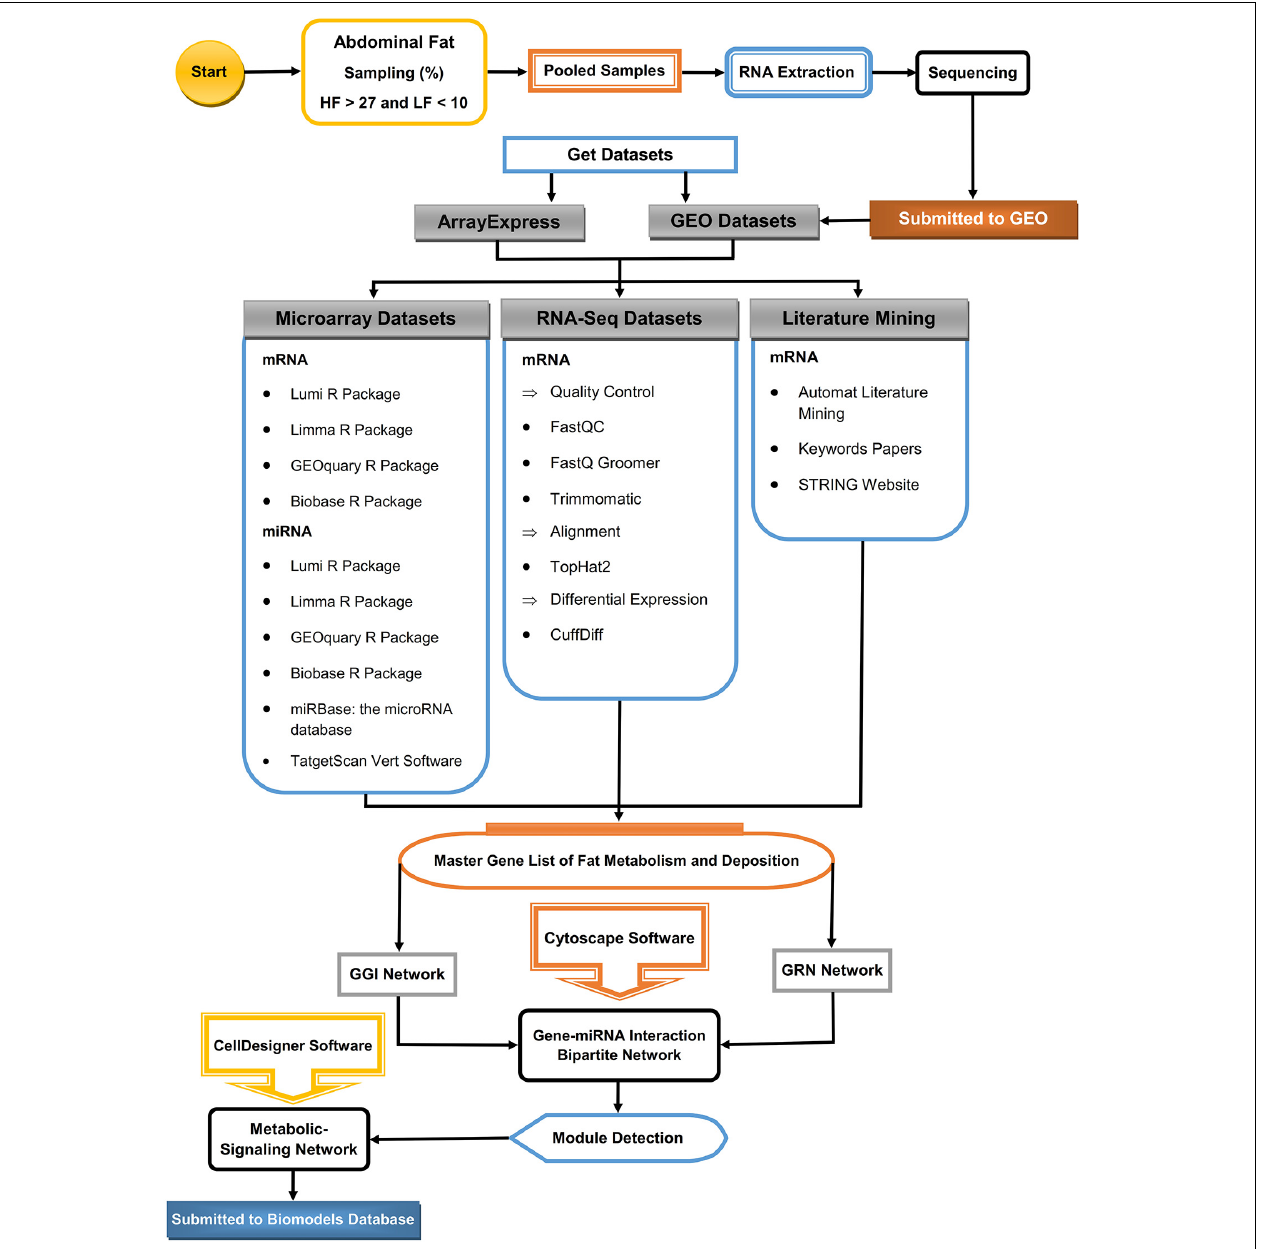
FIGURE 1 | Schematic for analysis view of the workflow to reconstruct the metabolic pathways of abdominal fat storage in poultry. The main gene list was prepared from three RNA-Seq and microarray data sets. The Gene–Gene Interaction Network (GGI), Gene Regulatory Network (GRN), and interactive bi-partite network of gene–miRNA network were reconstructed using Cytoscape. Functional modules were detected using related plugin in Cytoscape and the metabolic-signaling network using CellDesigner.